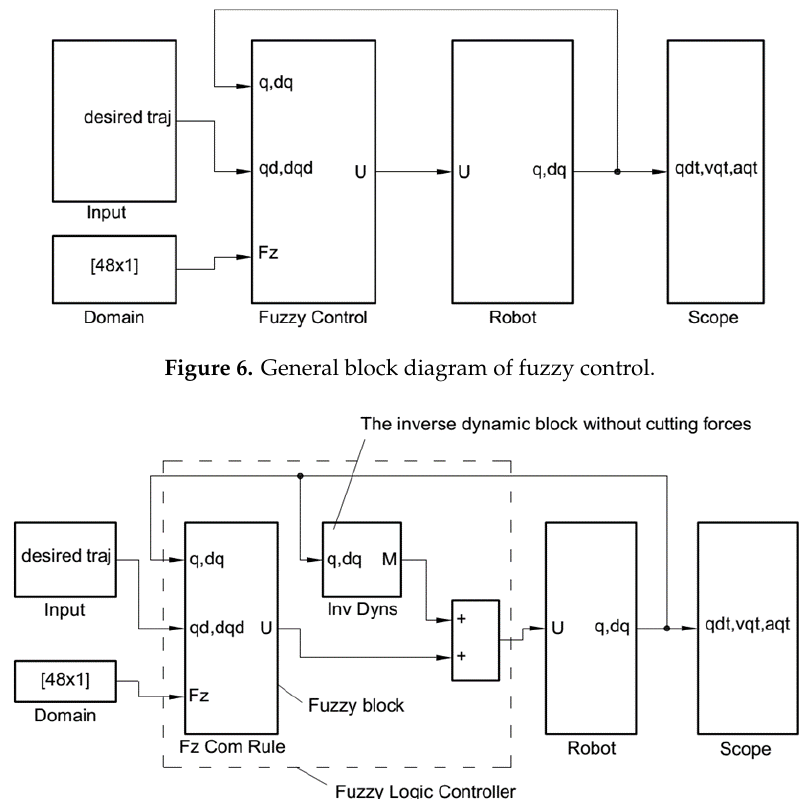
Figure 7. Block diagram of dual-loop fuzzy control.